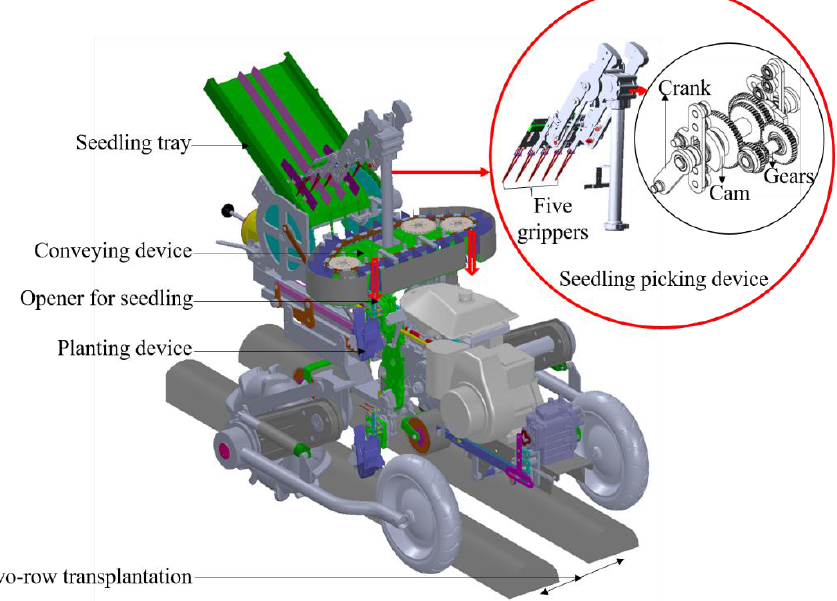
Figure 1. Overall structure of the automatic pepper seedling transplanter under development.